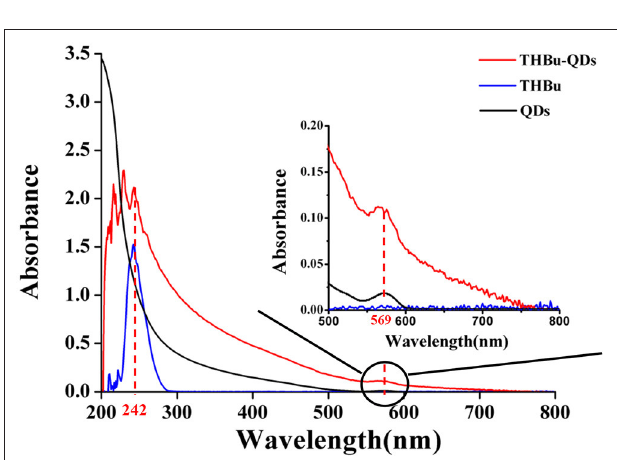
FIGURE 2 | UV-Vis spectra of THBu-QDs (red line), THBu (blue line), and QDs (black line).